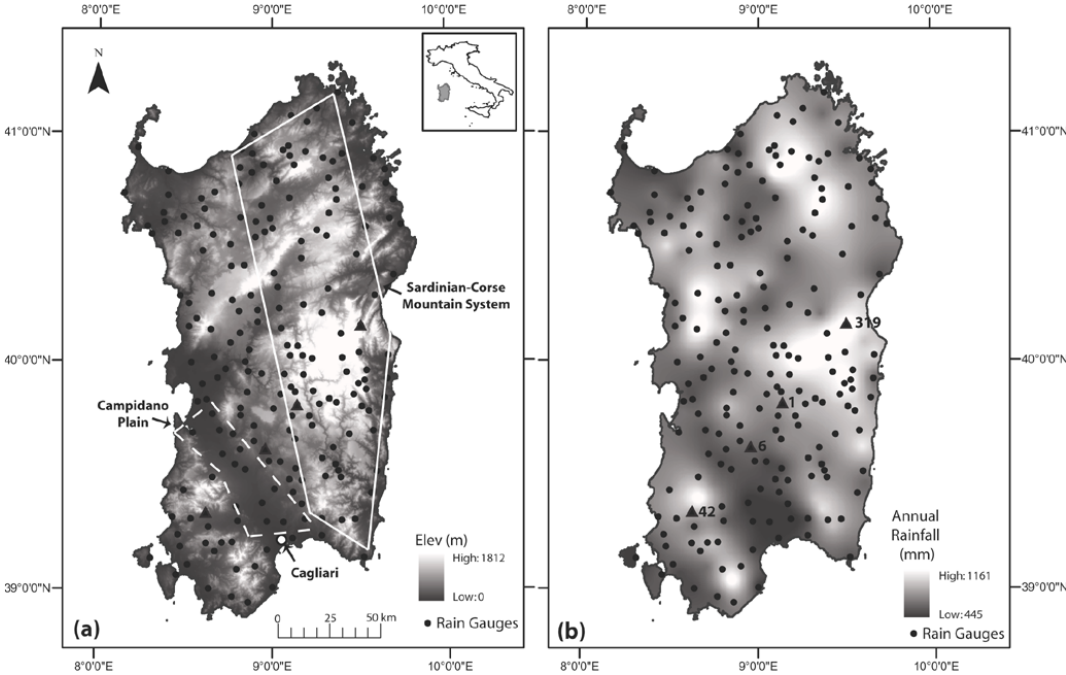
Fig. 1. (a) Digital elevation model of Sardinia (Italy). The inset shows the geographic location of the island with respect to the Italian peninsula. The polygons delimited by dashed and continuous white lines are the approximate boundaries of the Campidano plain and of the Sardinian–Corse Mountain System, respectively. (b) Spatial distribution of the annual rainfall. In both panels, the black circles indicate the location of the 201 stations used for the analyses, while the triangles identify the gauges with IDs 1, 6, 42 and 319 adopted as representative cases for the subsequent